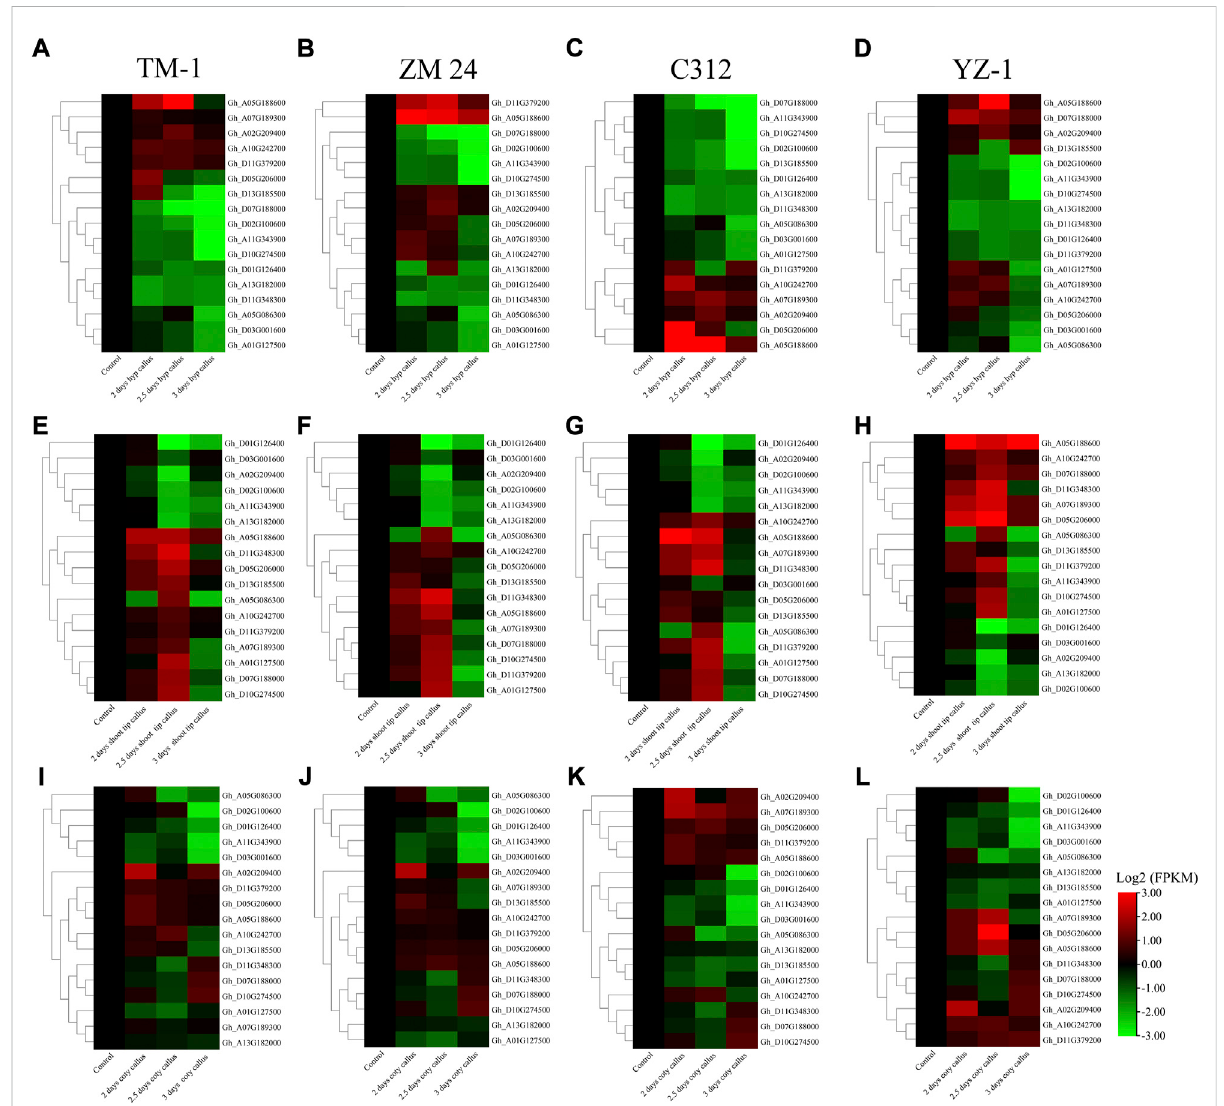
FIGURE 5 Expression pro fi le of 16 WOX genes in shoot tip, hypocotyls, and cotyledon-induced callus in four different varieties. (A) Callus induced from hypocotyls in TM-1, (B) callus induced from hypocotyls in ZM24, (C) callus induced from hypocotyls in YZ-1, (D) callus induced from hypocotyls in C312, (E) callus induced from the shoot in TM-1, (F) callus induced from the shoot in ZM24, (G) callus induced from the shoot in YZ-1, (H) callus induced from the shoot in C312, (I) callus induced from cotyledon in TM-1, (J) callus induced from cotyledon in ZM24, (K) callus induced from cotyledon in YZ-1, and (L) callus induced from cotyledon in